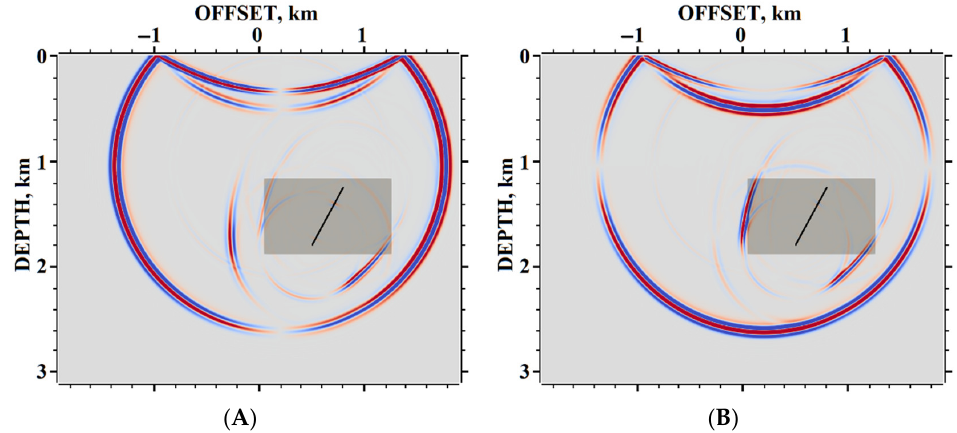
Figure 26. Example #2, snapshots at the time moment of 0.555 s: ( A ) horizontal component of veloc- ity; ( B ) vertical component of velocity.